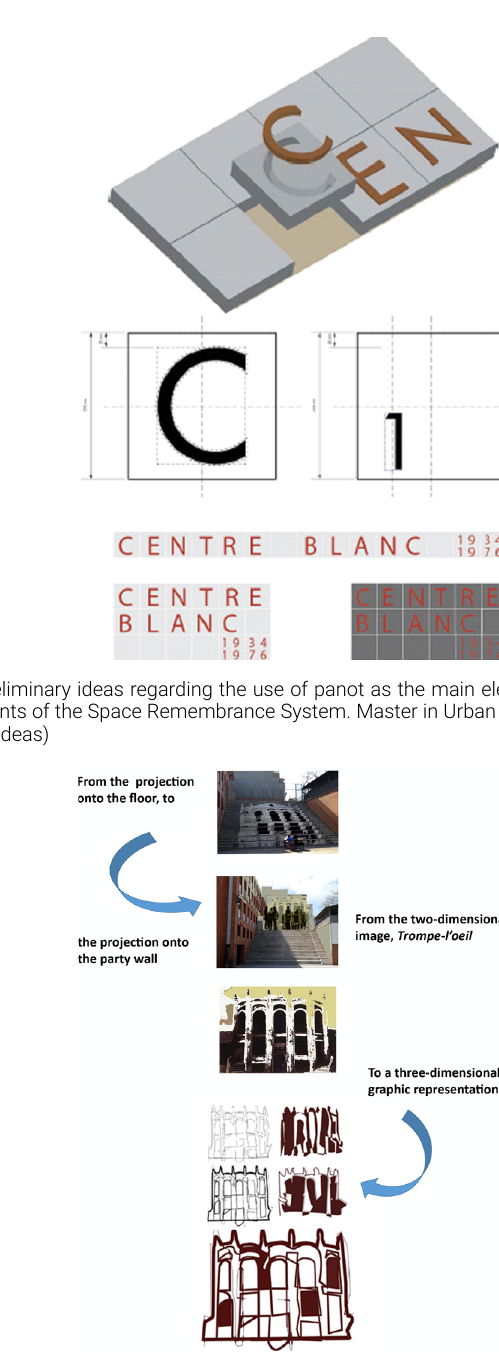
The Community Centre of the neighbourhood is located in the place that for many years was the site of the so-called “White Centre”, a reference for social move- ments. Monument preliminary study by Monica Bellido (M.A. in Urban